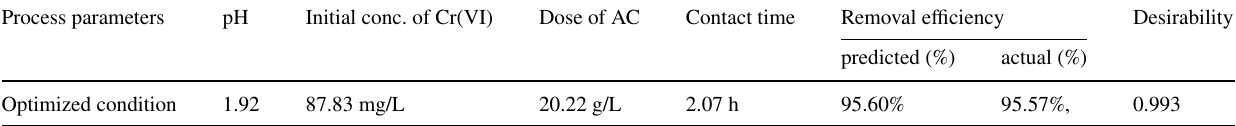
Fig. 4 Plot of a Langmuir isotherm model, b Freundlich isotherm model fitness at conditions of: volume of solu- tion = 100 mL, initial Cr(VI) concentration = 100, 150, 200, 250 mg/L, pH = 2, amount of THAC = 2 g, contact time = 2h at temperature of 25 °C